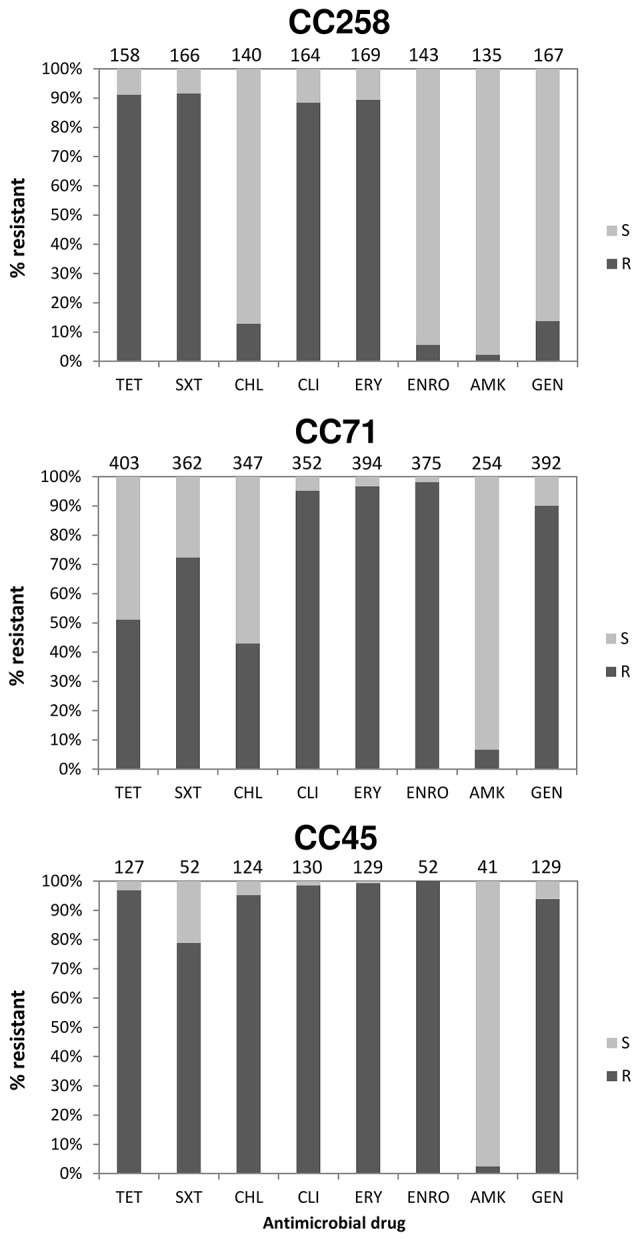
Proportion (%) of MRSP isolates resistant to selected antimicrobial drugs within three predominant clonal complexes (characterized by MLST-7). Antimicrobial susceptibility patterns were extracted from references given in Table S1. S, Susceptible; R, Resistance; TET, Tetracycline; SXT, Trimethoprim/Sulfamethoxazole; CHL, Chloramphenicol; CLI, Clindamycin; ERY, Erythromycin; ENRO, Enrofloxacin; AMK, Amikacin; GEN, Gentamicin.